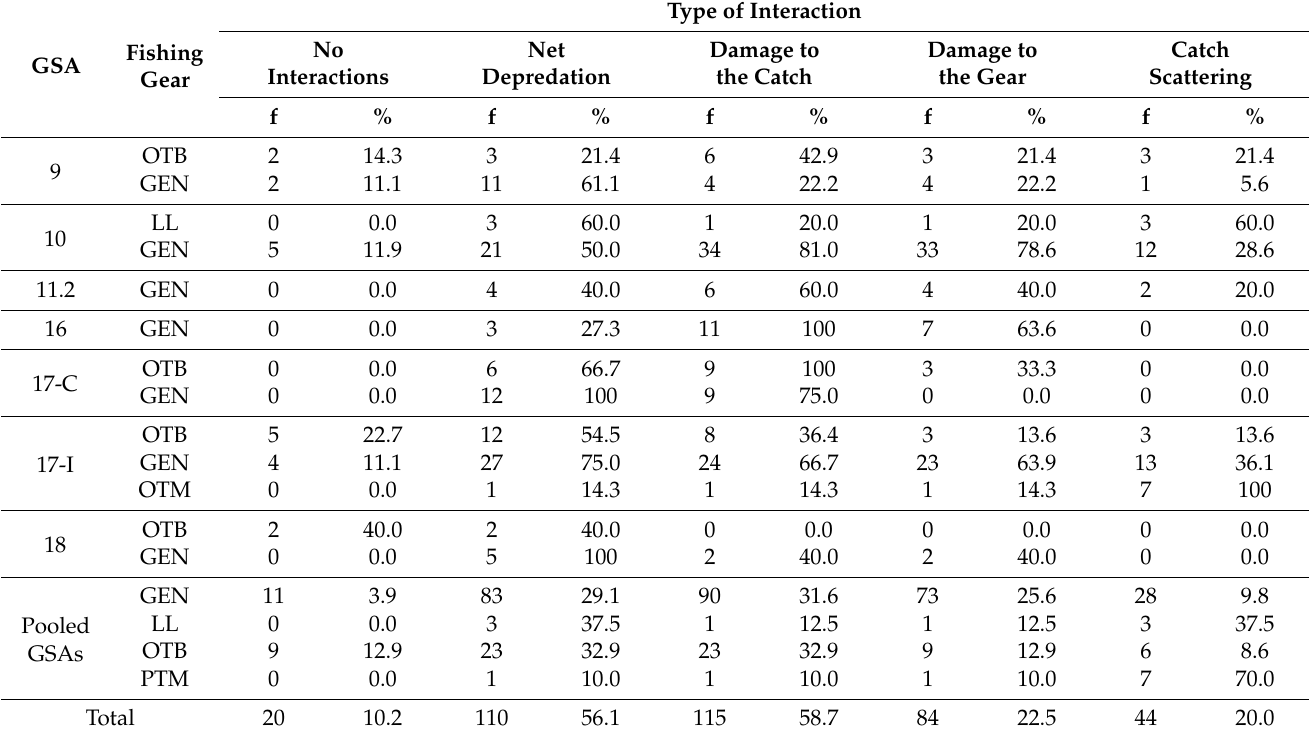
Table 1. Type of interaction reported by fishers grouped by GSA and fishing gear. OTB: bottom trawls; GEN: set nets; LL: longlines; PTM: mid-water pair trawls; f: frequency for each answer, in both number of answers and